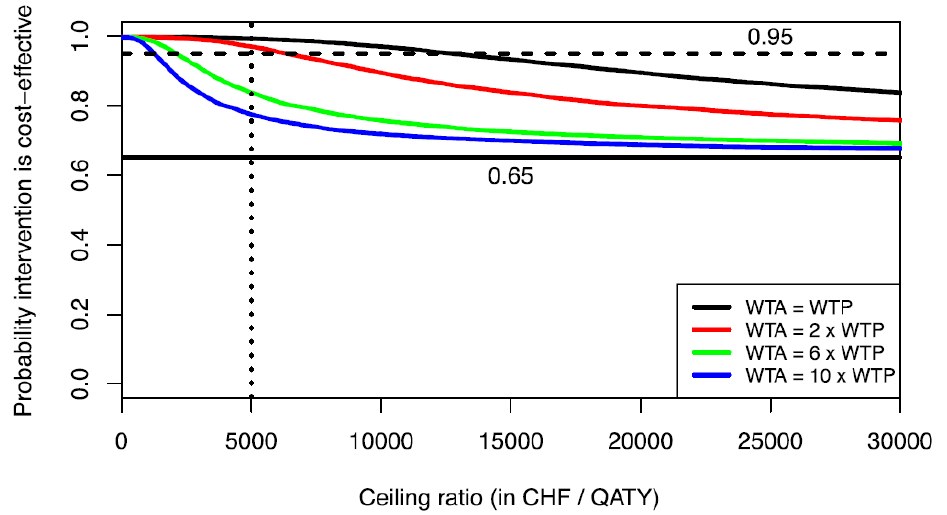
Figure 4. Cost-effectiveness acceptability curves for different WTA/WTP ratios. Horizontal line at 0.65 indicates probability of dominance; horizontal line at 0.95 indicates threshold line for hypothesis testing within a frequentist framework.